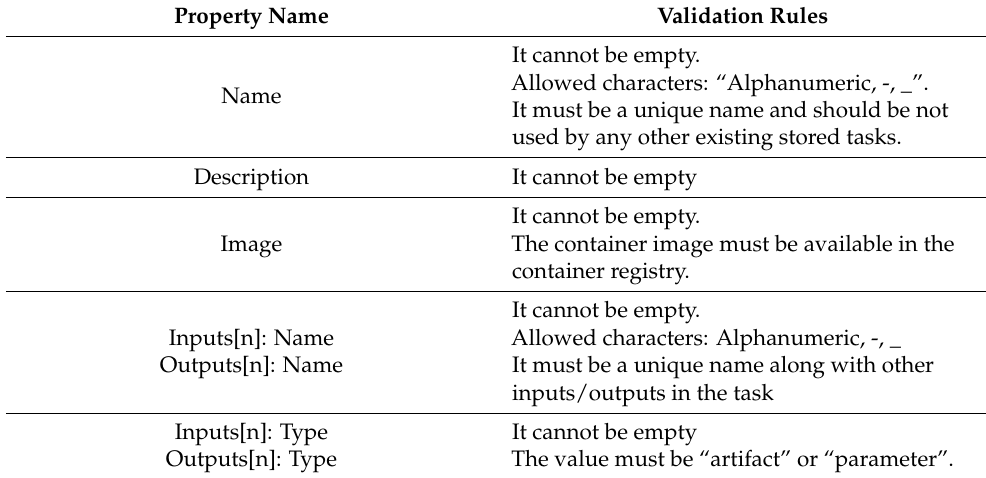
Table 1. Validation rules for task definition properties.